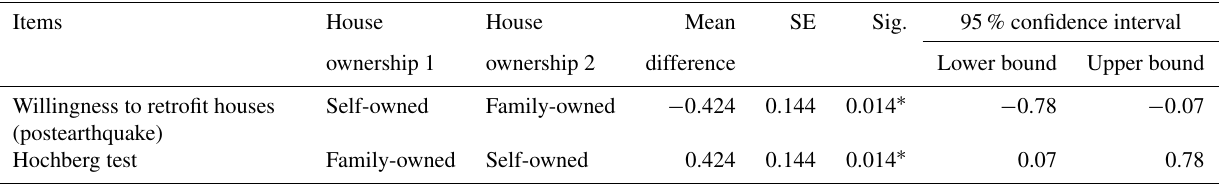
Table 10. Post hoc results for house ownership (for the categories compared across the two house ownership columns.